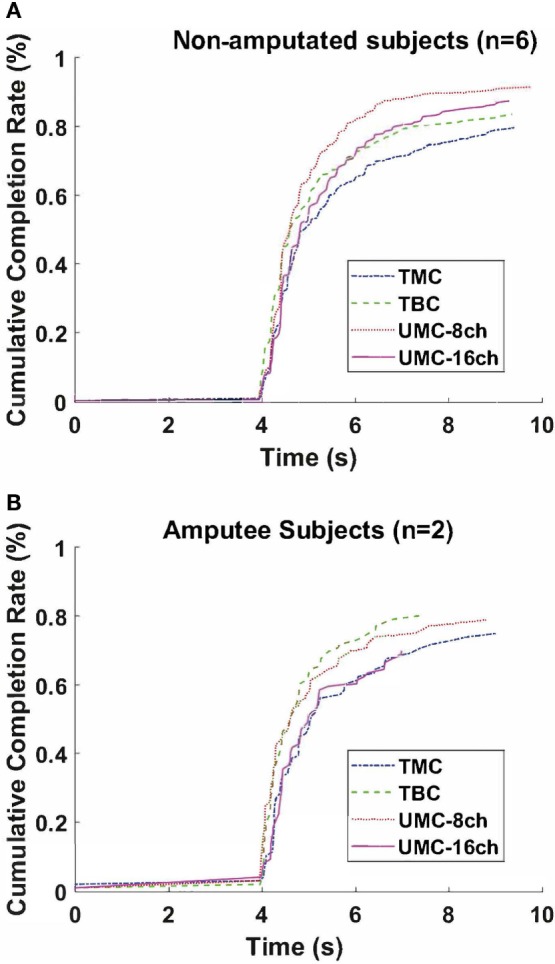
Cumulative completion rate for (A) non-amputated and (B) amputated subjects.